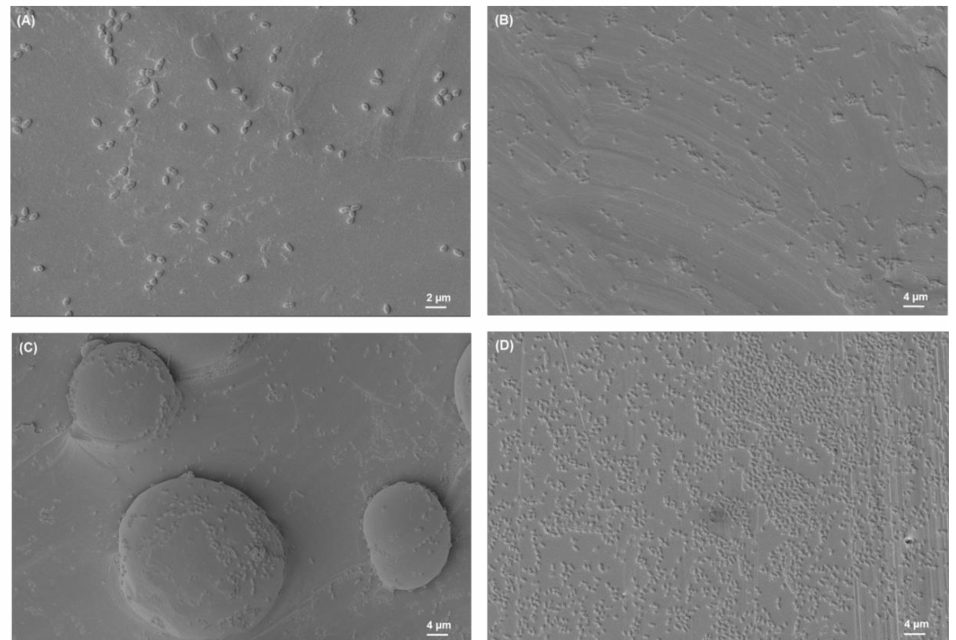
Figure 5. E. faecalis biofilm on ( A ) Ti grade 23, ( B ) Ti grade 2, ( C ) Ti grade 5, ( D ) Ti grade 5 polished. All images were recorded at high voltage of 5 kV, magnification = 1.18 KX with scale bars = 4 µ m (except image (A), magnification = 2.22 KX, scale bar = 2 µ m).